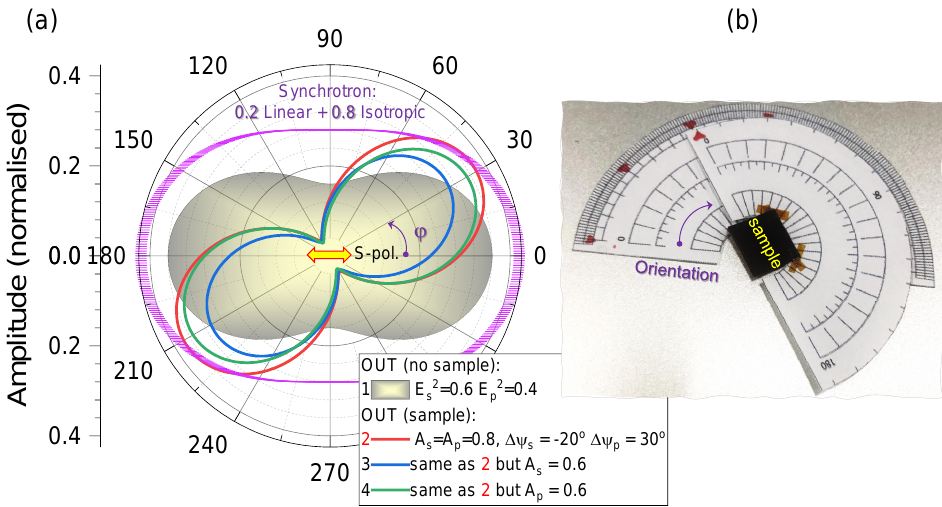
Figure 6. Numerical example of polarisation analysis at the ATR output (OUT) based on Equation (4). The angular dependence of synchrotron THz radiation (at THz beamline) comprised of 20% linear polarisation and 80% isotropic (circular) [28] is shown. ( b ) Sample holder for four-polarisation (4-Pol) ATR measurements: instead of changing the linear polarisation of light beam (THz), the sample orientation can be changed. Sample shown is isotropic THz absorber—black